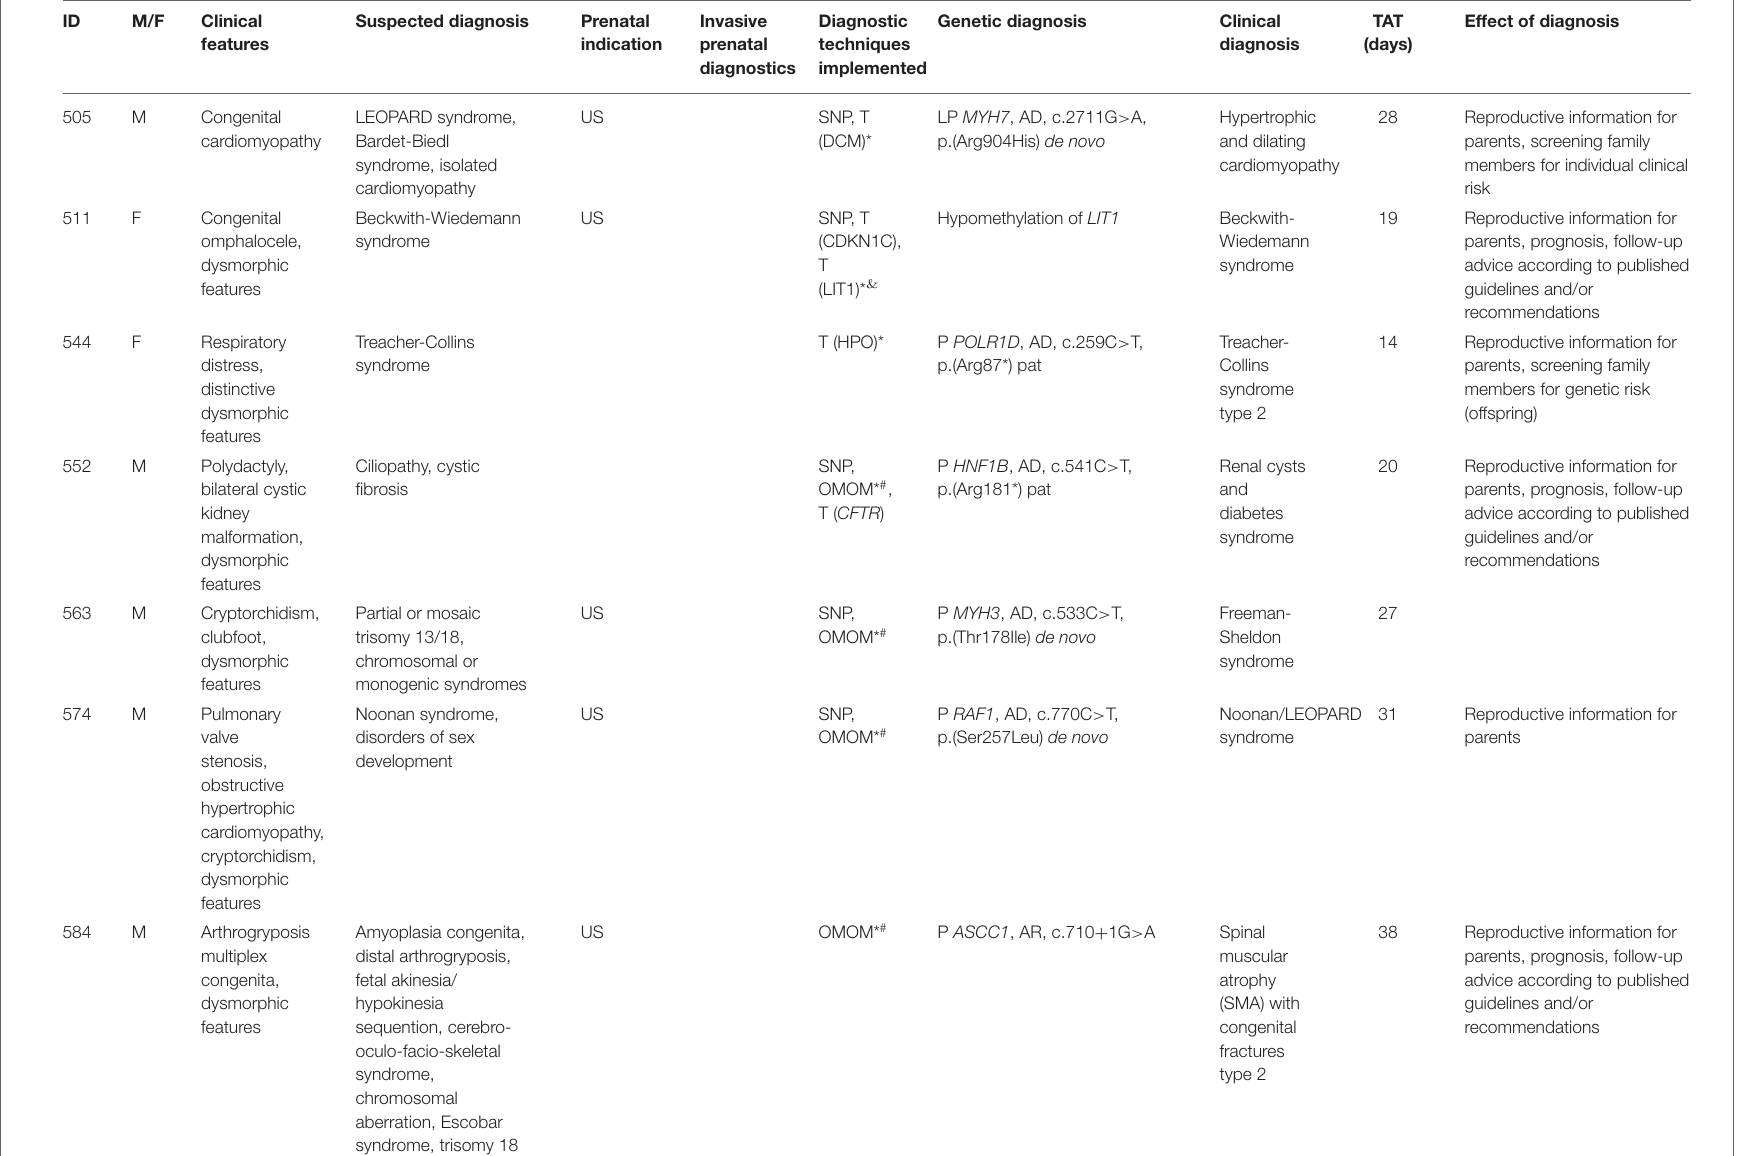
TABLE 2 | Diagnoses made with Next Generation Sequencing based